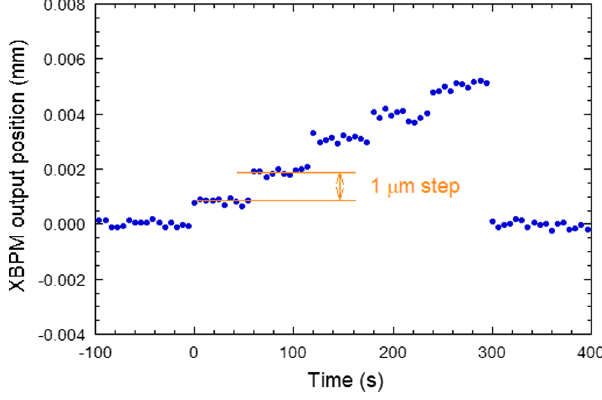
FIG. 24. Results of scan measurement with scan steps of 1 μ m.